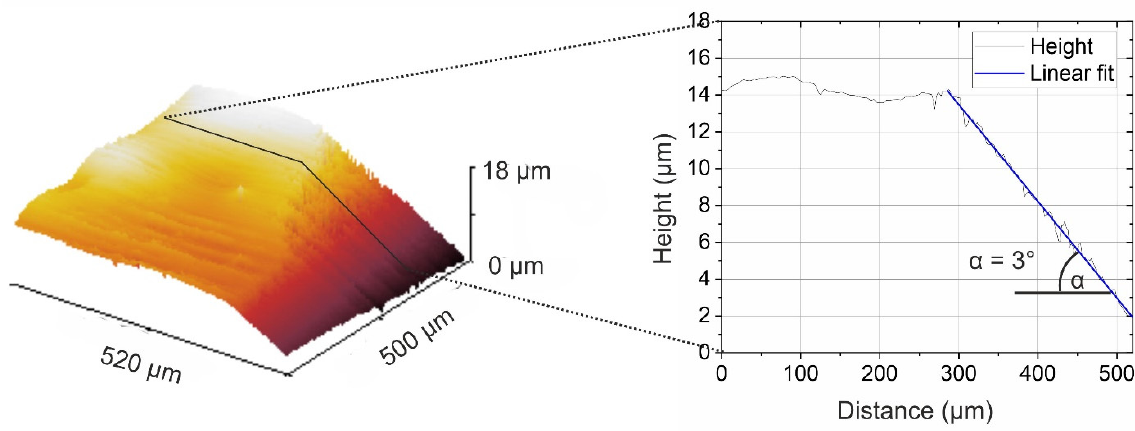
Figure 6. White light interferometric 3D image ( left ) and linescan ( right ) of the cut.